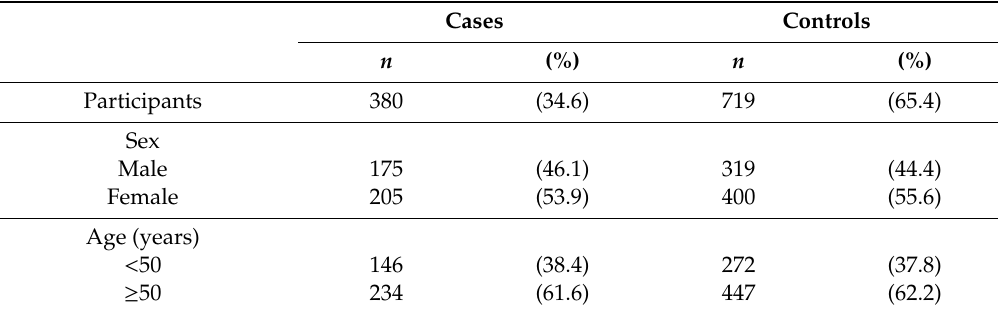
Table 1. Baseline characteristics of study